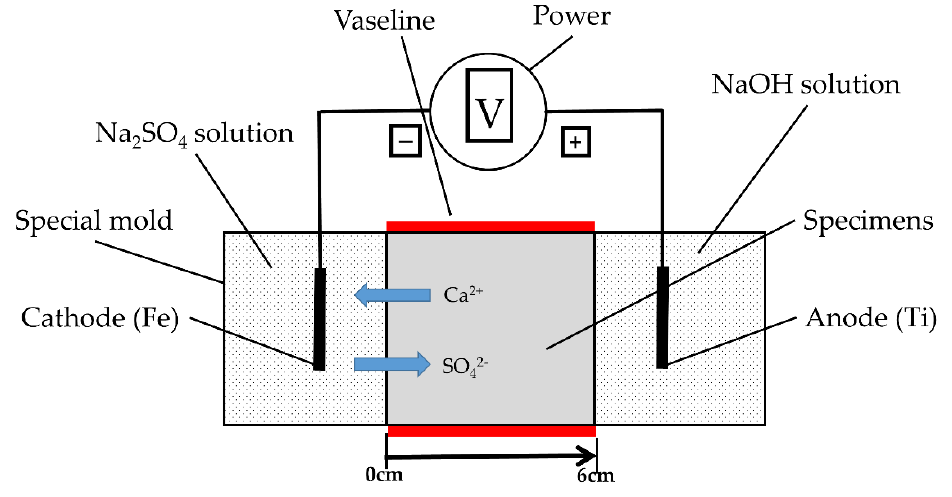
Figure 9. Schematic drawing of combined action test of sulfate attack and lelctrical field